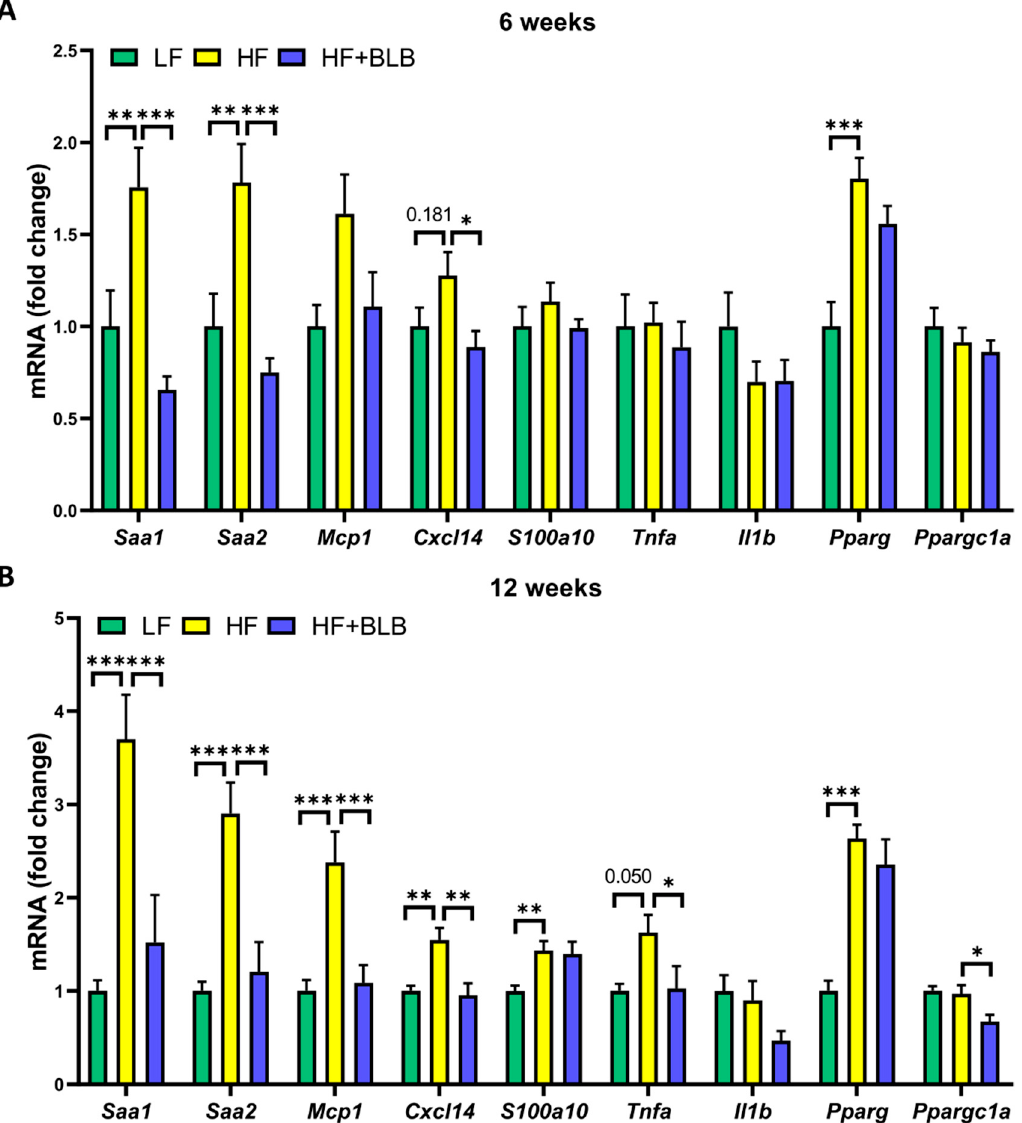
Figure 6. Gene expression in the hepatic tissue. The mice received a low-fat diet (LF, 10% energy from fat), a high-fat diet (HF, 46% of energy from fat) or a bilberry-supplemented high-fat diet (HF+BLB, 20% air-dried bilberry powder) for six ( A ) or twelve ( B ) weeks. The gene expression was measured with RT–PCR and normalized against the housekeeping gene glyceraldehyde 3-phosphate dehydrogenase ( Gapdh ). The expression levels were then compared to the mean expression level in the LF group, which was set to 1. The results are expressed as a fold change and analyzed with a one-way ANOVA and a Bonferroni multiple comparisons test. The statistically significant differences from the HF group are marked with * p < 0.05, ** p < 0.01, and *** p < 0.001. Values represent mean + SEM; n = 12 mice in each group. Saa1 = Serum amyloid A1, Saa2 = Serum amyloid A2, Mcp1 = Monocyte chemoattractant protein 1, Ccxl14 = Chemokine (C-X-C motif) ligand 14, S100a10 = S100 calcium-binding protein A10, Tnfa = Tumor necrosis factor α , Il1b = Interleukin-1 β , Pparg = Peroxisome proliferator-activated receptor γ , Ppargc1a = Peroxisome proliferator-activated receptor γ coactivator 1 α .